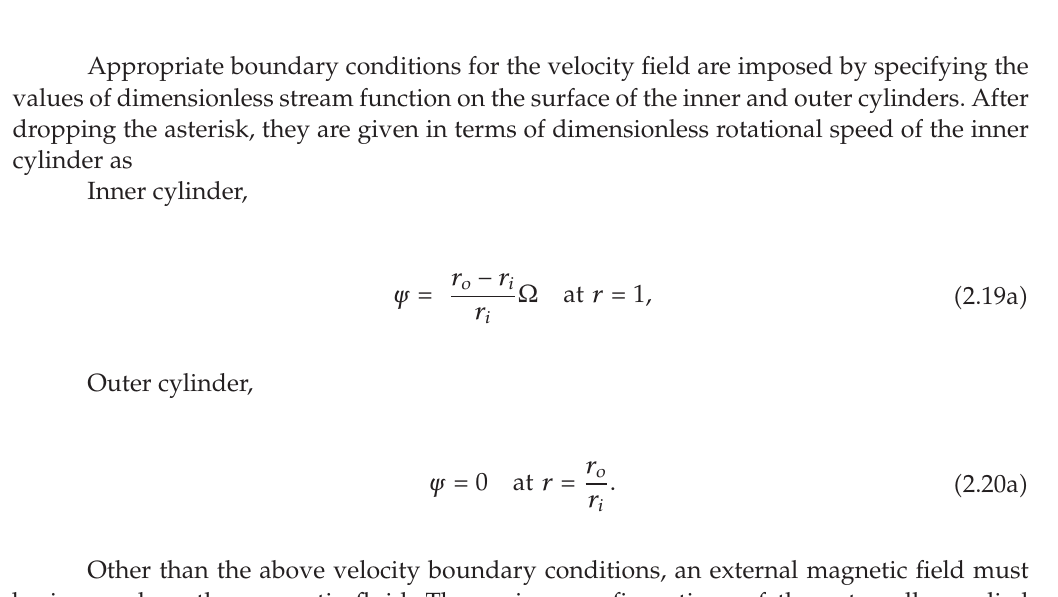
Figure 1: Distribution of externally applied magnetic fields: (cid:2) a (cid:3) uniform, (cid:2) b (cid:3) a semicircular, (cid:2) c (cid:3) two-quarter circular, and (cid:2) d (cid:3) a three-quarter